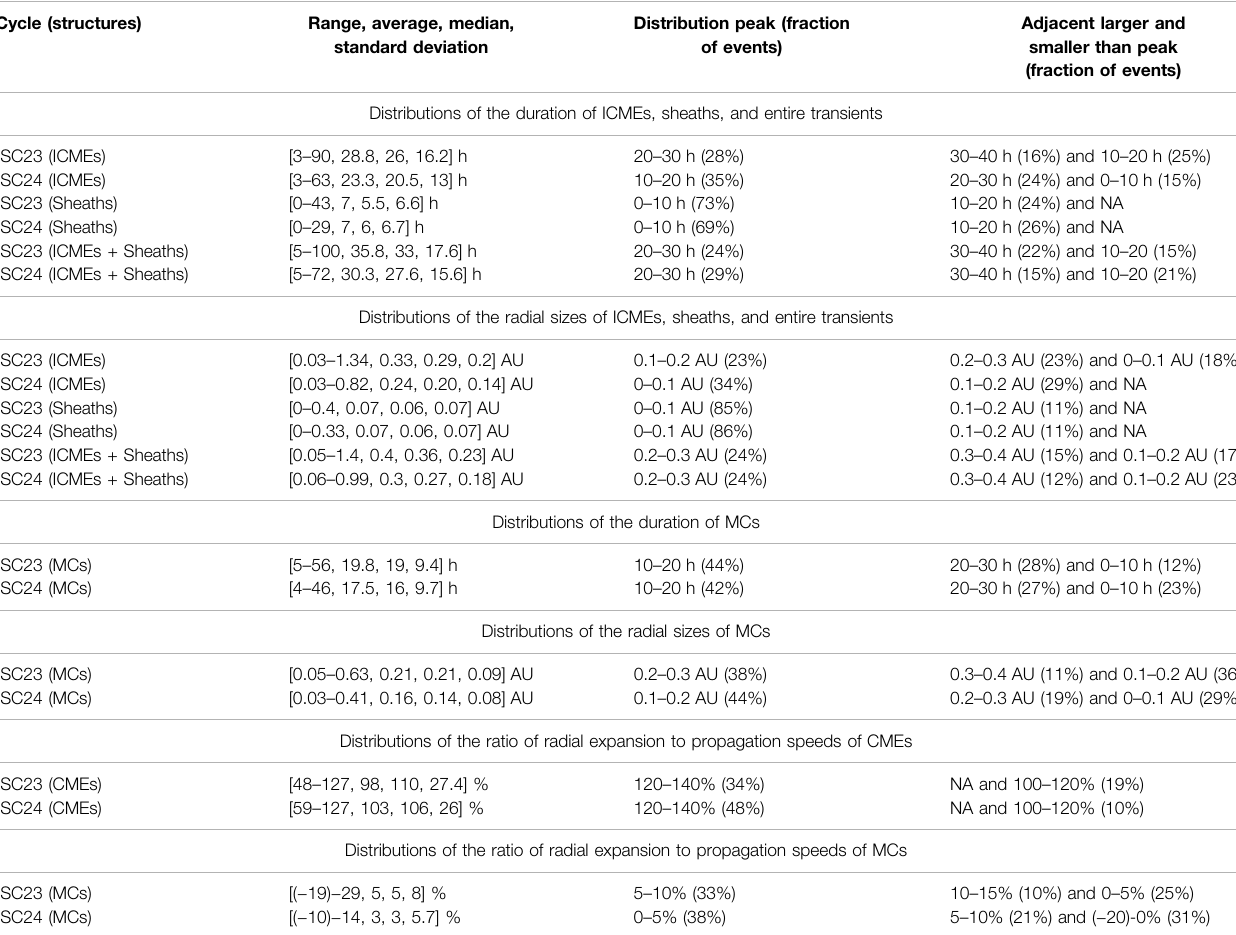
TABLE1| ThestatisticsofdistributionsofdurationandradialsizesofdifferentICMEsstructuresat1 AUforsolarcycles23and24arelisted.Fromthetop:thedistributionof the duration of ICMEs, sheaths, and entire transients ( fi rst panel); the radial sizes of ICMEs, sheaths, and entire transients (second panel); the duration of MCs (third panel); and the radial sizes of MCs (fourth panel). The ratio of radial expansion to radial propagation speeds of associated CMEs near the Sun and MCs at 1 AU is in the fi fth and sixth panels, respectively. From the left: the solar cycle and structures ( fi rst column); the range, average, median, and standard deviation (second column); peak of the distribution havingfractionoftotalnumber ofevents(third column);adjacent largerand smaller thanthedistributionpeak having fraction oftotalnumberofevents(fourth column). Cycle